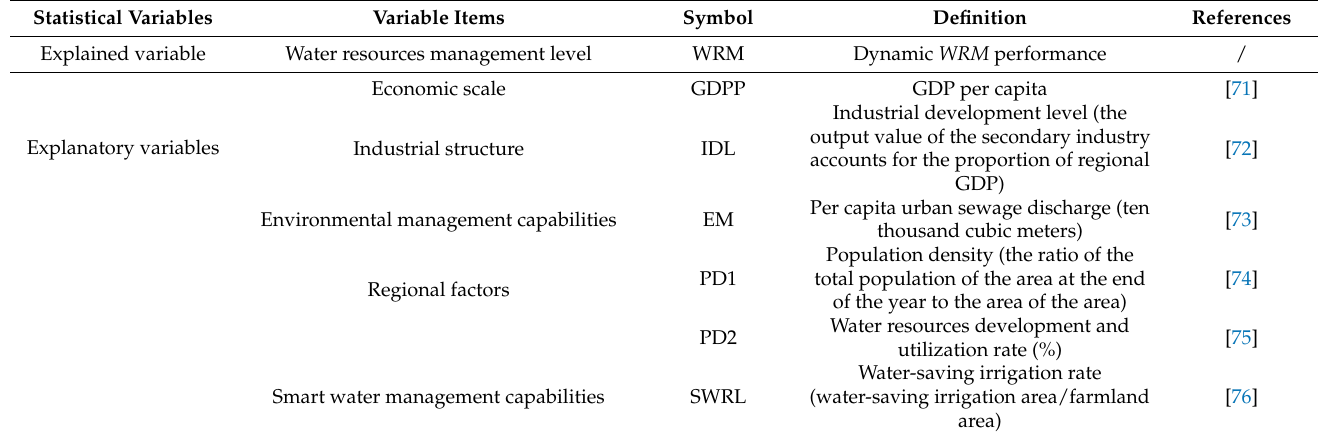
Table 3. Definition of the variables of the WRM performance and influencing factors.